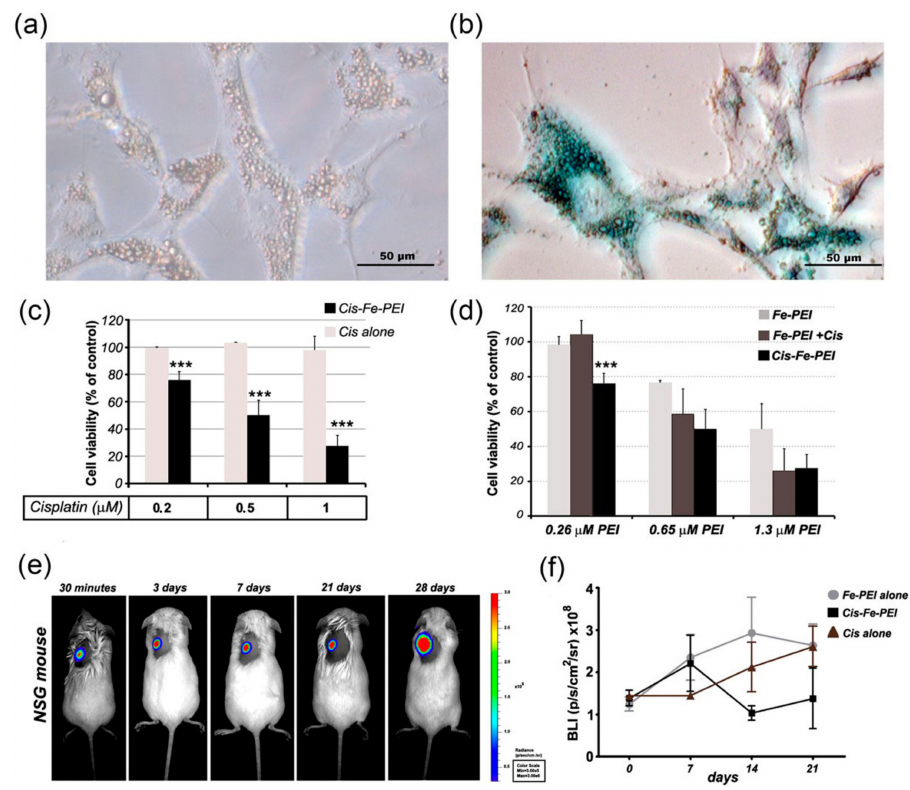
Figure 4. Increased efficiency of cisplatin drug on tumor cell death upon incorporation into Fe-PEI NPs during synthesis process. ( a ) Optical microscopy image showing the specific accumulation of Fe-PEI NPs onto tumor cell surface; ( b ) Optical microscopy image illustrating the appearance of blue aggregates on U87 cells after 24-h co-culture with Fe-PEI NPs; ( c ) Diagram illustrating U87 viability as determined by luciferase activity measured with IVIS after three days of culture in the presence of cisplatin alone or cisplatin incorporated into Fe-PEI during assembling process (Cis-Fe-PEI); ( d ) Diagram illustrating U87 cell viability (determined by luciferase activity, as in ( b ) in the presence of Fe-PEI, Cis-Fe-PEI (Cis added during Fe-PEI assembling), and Fe-PEI+Cis (cisplatin added post-synthesis), at various dilutions (equivalent of 0.26, 0.65, and 1.3 µ M PEI, respectively); ( e ) Time-dependent tumor development after in vivo injection of 2 × 10 6 cells into NSG mouse; ( f ) Initial tumor development in mice injected with U87 cells in the presence of 50 µ L Cis-Fe-PEI (containing 0.5 µ M Cis) applied at weekly